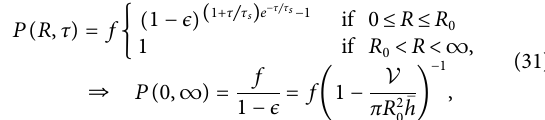
A plot of P (0, ∞ )/ f as a function of V / ( π R 2 Figure 7. As discussed in Supplementary Appendix D, the solution Eq. 31 can be used to obtain a simple upper bound on the rotational fl ow v ( r , t ). If we regard R 0 as fi xed, the abscissa of Figure 7 can be interpreted as a measure of the total volume of fl uid removed by the mass sink. If the total volume of fl uid